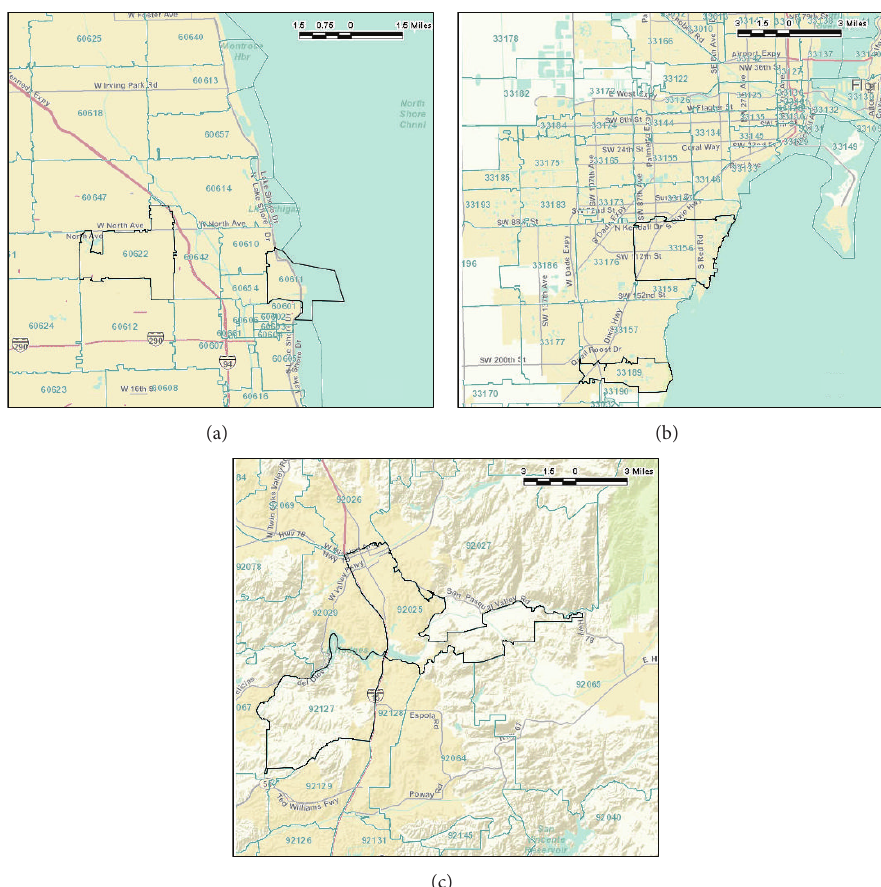
Figure 1: Selected zip codes in (a) Cook County, (b) Miami-Dade County, and (c) San Diego County.